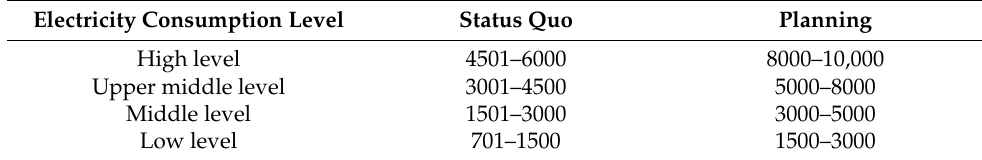
Table 5. Annual electricity consumption per capita (kWh/(person · year))